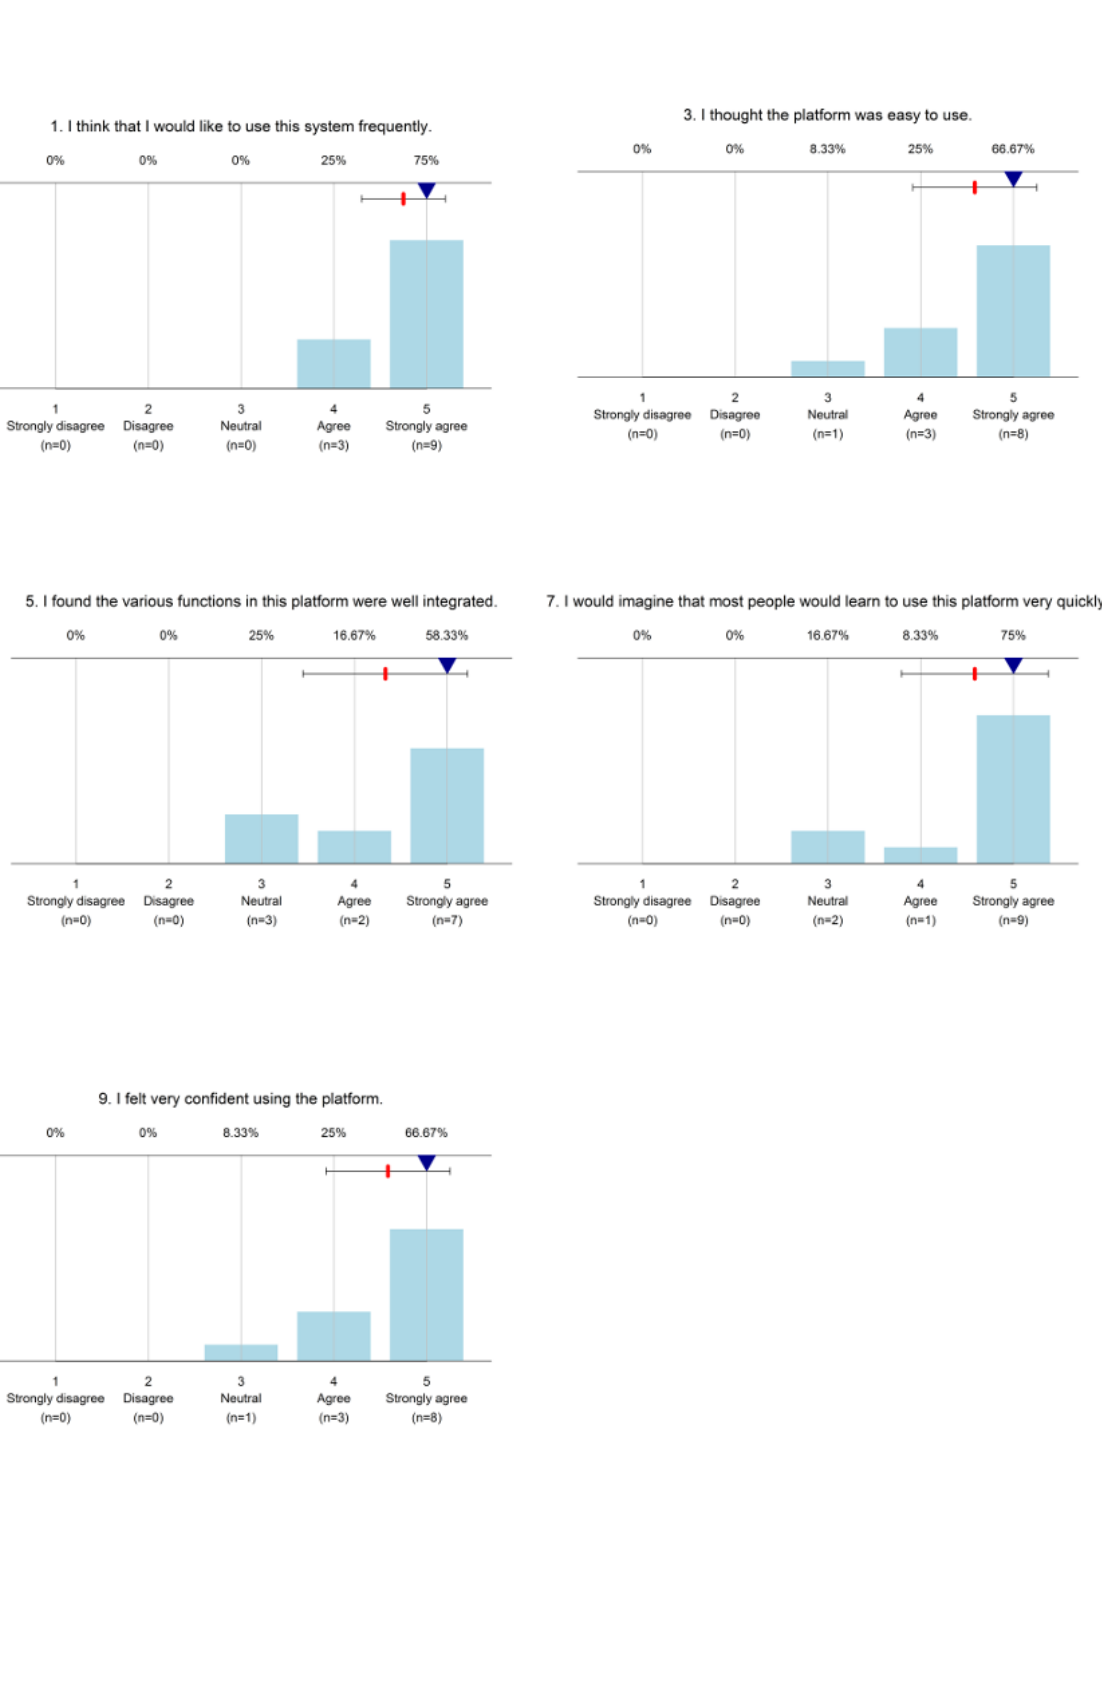
Figure 5. Usability questionnaire response for positively articulated questions in the System Usability Scale (SUS) used during a survey in a demographic survey site in 2016, Dabat, northwest